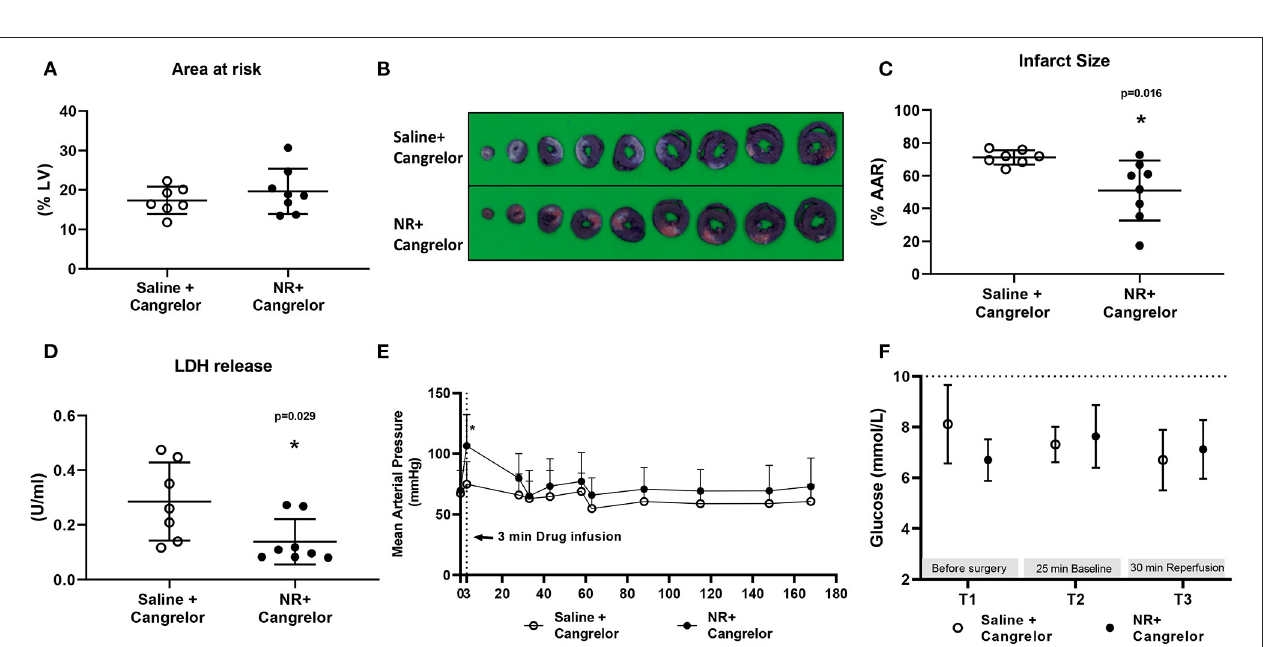
FIGURE 4 | Blood glucose level from the 5 experimental groups at three time points. Glucose (mmol/L) levels were detected before surgery, at 25min baseline and 30min reperfusion. ** P < 0.01 vs. T1, data was analyzed using two-way Repeated Measures ANOVA applying the Bonferroni multiple comparisons test when relevant. All groups n = 6–8 experiments.